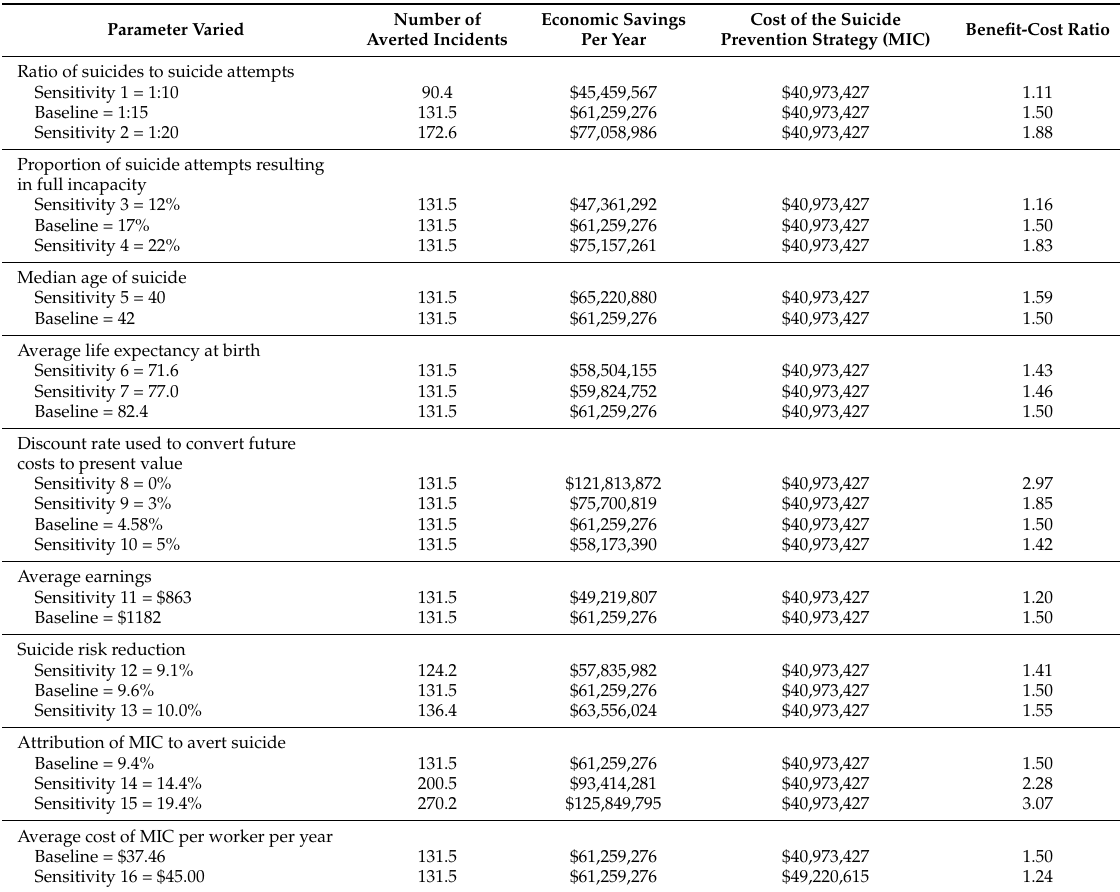
Table 8. Sensitivity analysis of key parameters (in Australian